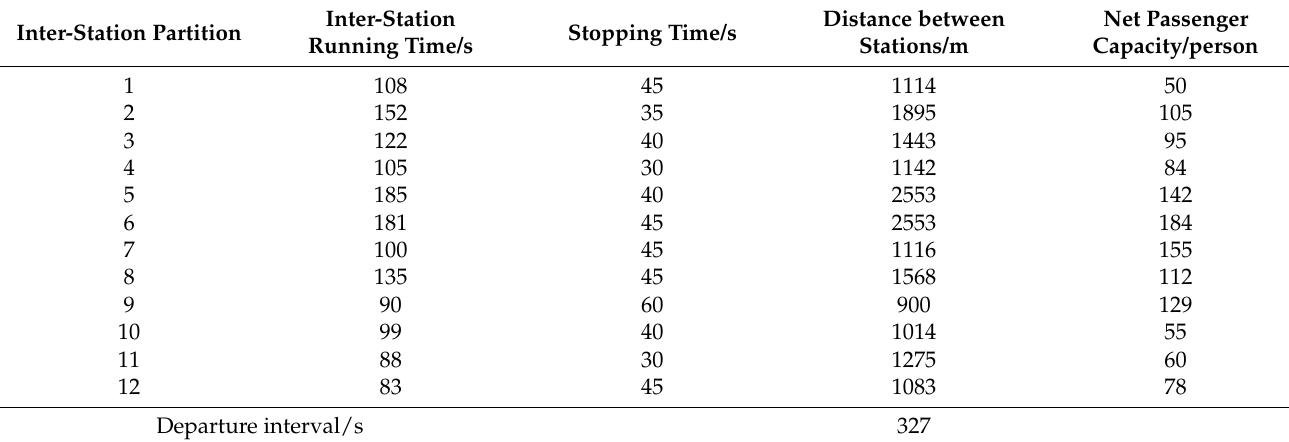
Table A5. Basic data of subway train line in City A.